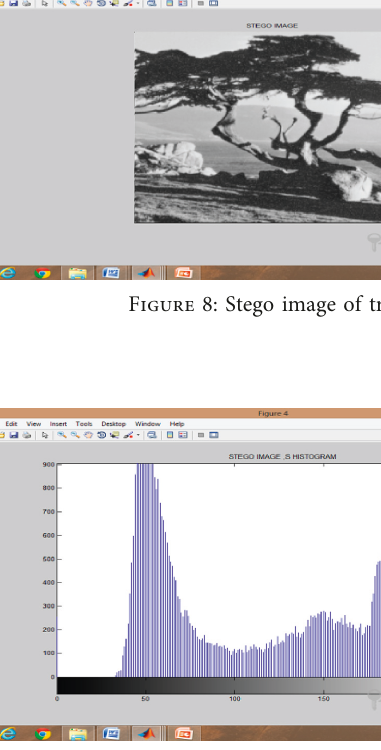
Figure 9: Histogram of original image of trees.